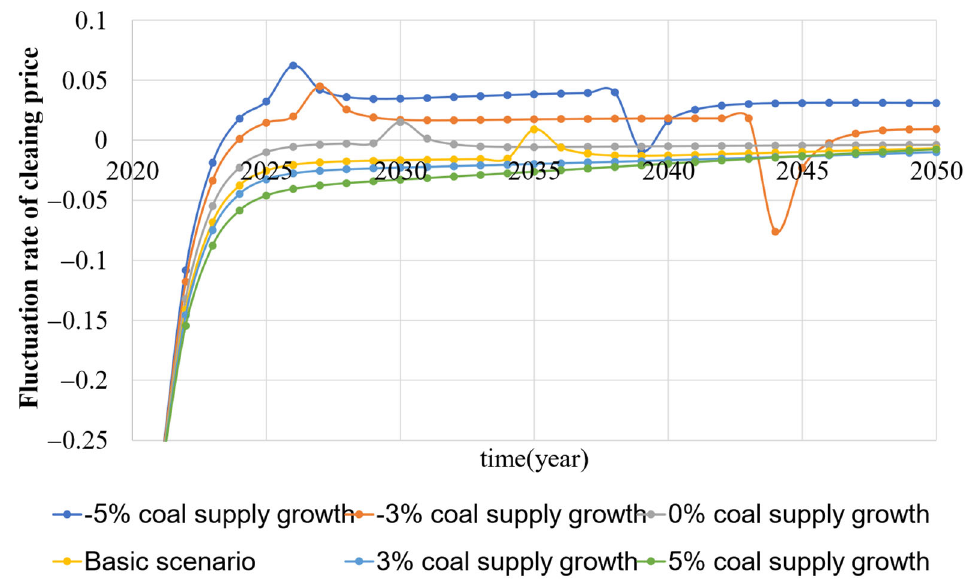
Figure 12. Fluctuation rate of clearing price based on coal supply growth rate.